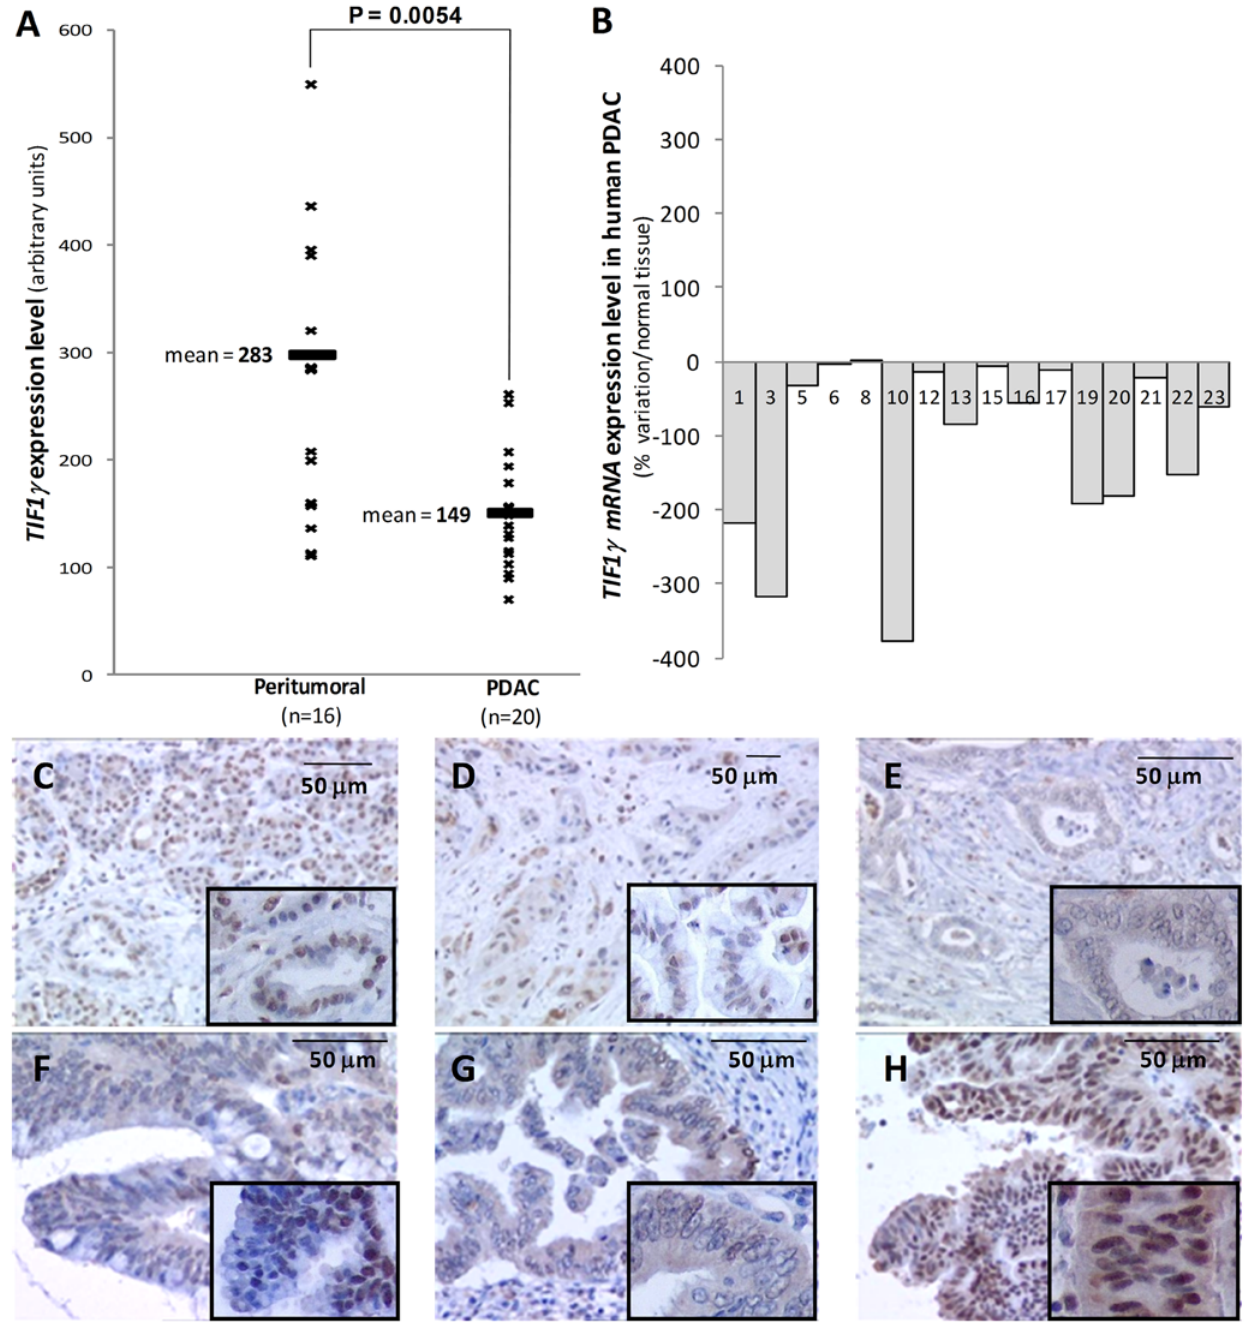
Figure 5. TIF1 c expression in human pancreatic neoplasia. The expression of TIF1 c from 20 human PDAC and 16 peritumoral tissues was determined by quantitative RT–PCR (A). The average expression ( 6 sd) is plotted for each group (B). The significance (P value) for the difference between peritumoral and tumoral groups, determined by a Student’s T test, is shown above the graphs. The expression of TIF1 c protein was evaluated by immunohistochemistry in different pancreatic lesions: PDAC (n patients=20) (peritumoral (C) and tumoral tissues (D, E). IPMN (n patients=10) of high grade dysplasia (F), high-grade PanINs (n patients=8) (G) and MCN (n patients=15) (H). Inset pictures: higher magnification.